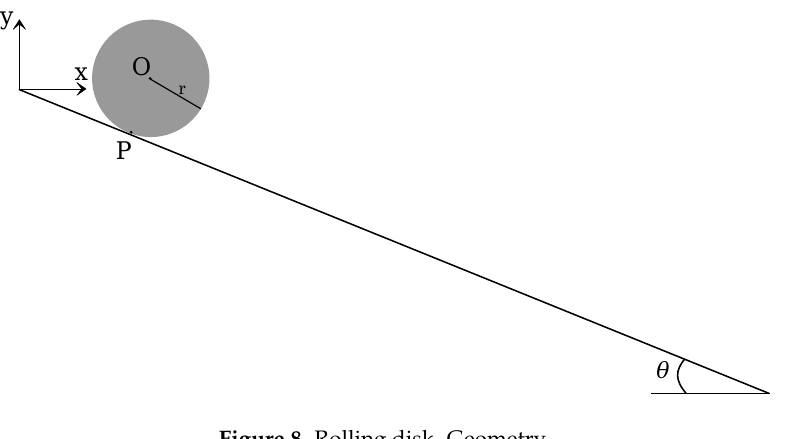
Figure 8. Rolling disk.